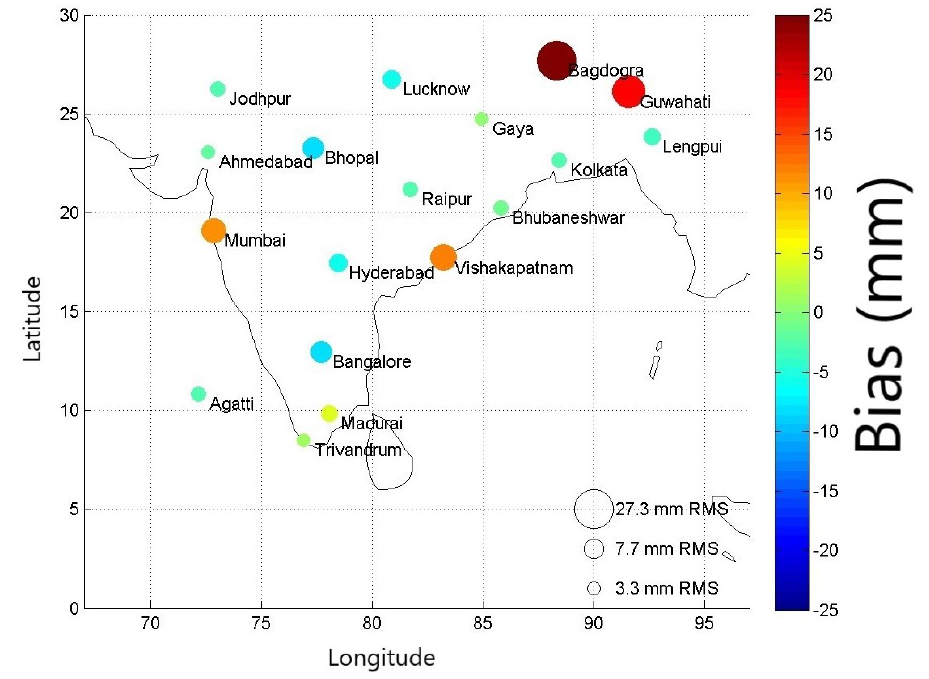
Figure 1. Bubble plot depicting station-wise comparison between GPS-derived IWV and IWV from ERA-I. (The colors depict the bias in mm for each station, and the size of the bubbles depict the